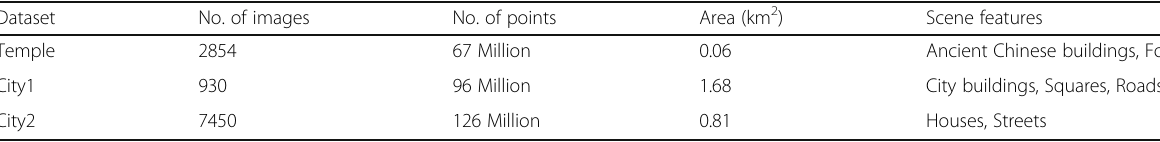
Table 1 The description of our datasets